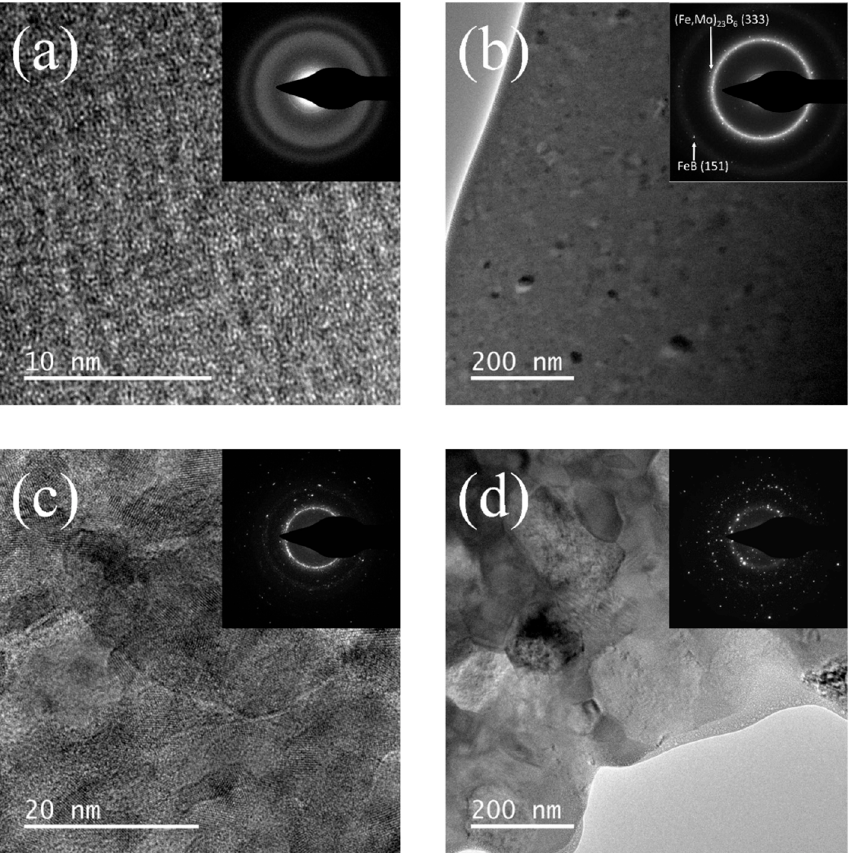
Figure 6. TEM micrographs of Fe 76 Si 7 B 10 P 5 Mo 2 ( a ) in the as-spun state, ( b ) annealed to 813 K, ( c ) annealed at 873 K, and ( d ) annealed at 1073 K. The samples were annealed at di ff erent temperatures using the NETZSCH DSC 404C for 60